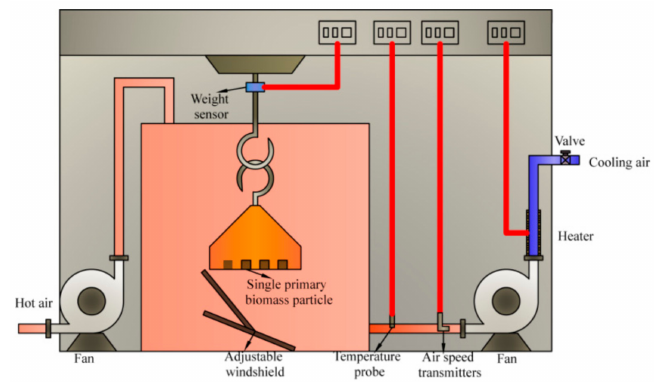
Figure 1. Hot air circulating